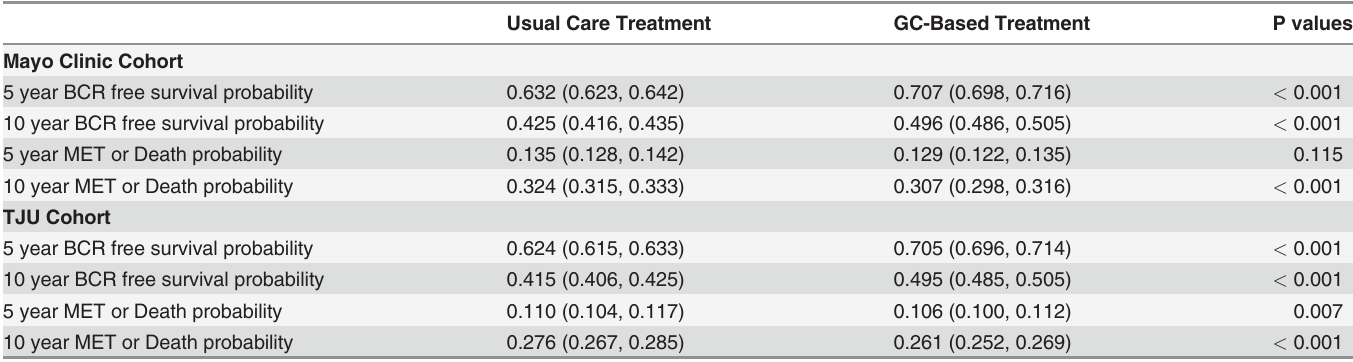
Table 3. Comparison of 5 and 10 year outcomes for usual care vs. genomics-based care decisions using individual level probabilities. Usual Care Treatment GC-Based Treatment P